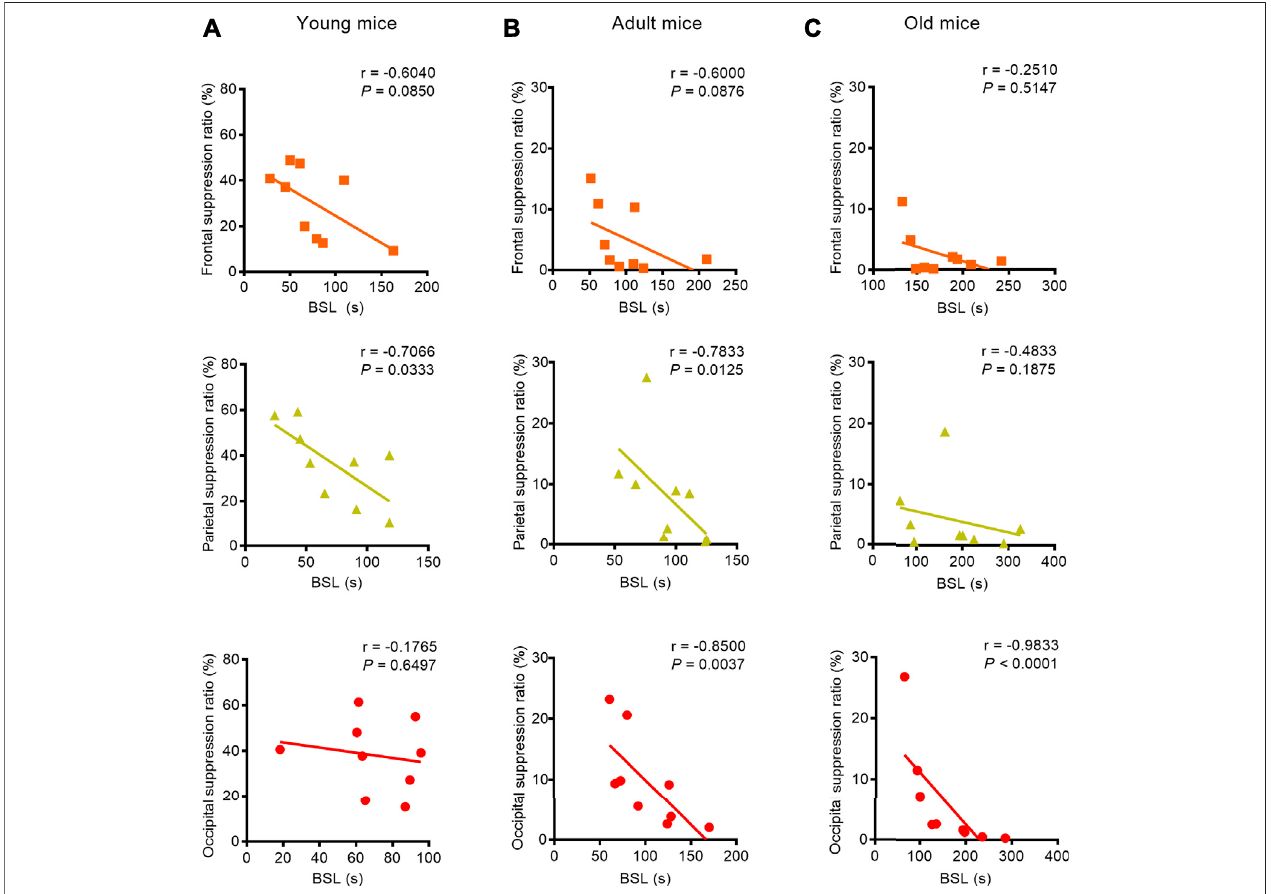
FIGURE 3 | Correlation between BLS and BSR in mice of different ages during the administration of 1.0% iso fl urane anesthesia. (A) A weak negative correlation between BSL and BSR in the frontal lobe ( n (cid:1) 9) and a strong negative correlation in the parietal lobe ( n (cid:1) 9) were found in young mice receiving 1.0% iso fl urane anesthesia,whiletheoccipitalEEGrecordingindicatednocorrelationbetweenBSLandBSR( n (cid:1) 9). (B) AweaknegativecorrelationbetweenBSLandBSRinthefrontal EEGrecording( n (cid:1) 9)andstrongcorrelationsbetweenBSLandBSRinparietalEEGrecording(n (cid:1) 9)andoccipitalEEGrecordings( n (cid:1) 9)werefoundinadultmice. (C) In old mice, the EEG recording in frontal and parietal lobes showed no correlation between BSL and BSR ( n (cid:1) 9, respectively), while a negative correlation was detected in the occipital EEG recording ( n (cid:1) 9).